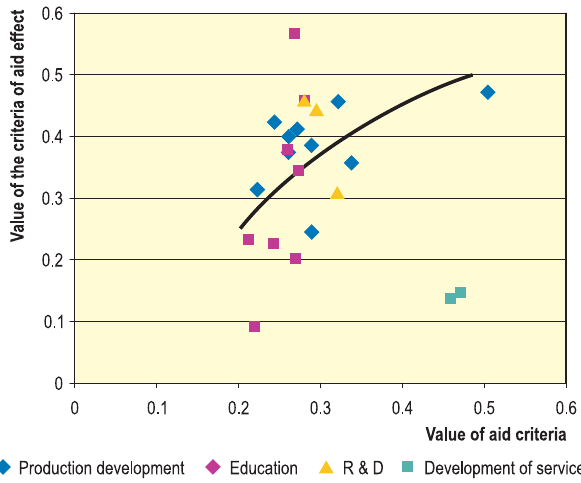
Fig. 2. The effect of aid to enterprises according to the areas of their activities calculated by TOPSIS (correlation coeffi cient – 0.48)